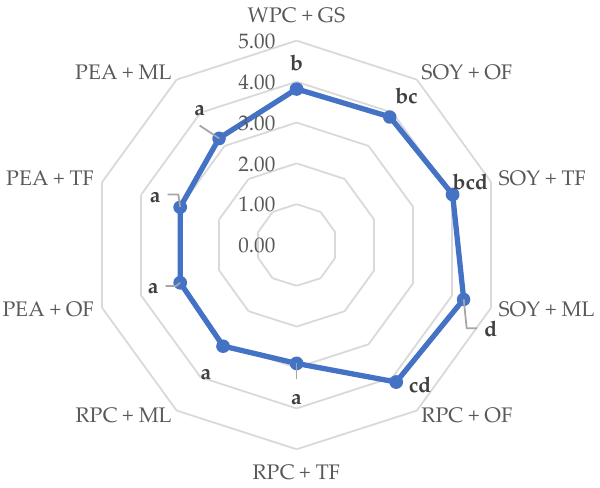
Figure 4. Influence of the combination of proteins and syrups on the sensory evaluation of the developed high-protein bars. The letters (a–d) indicate significant differences at p < 0.05 (Tukey’s HSD test). Fifteen trained evaluators participated in the study ( n = 15).